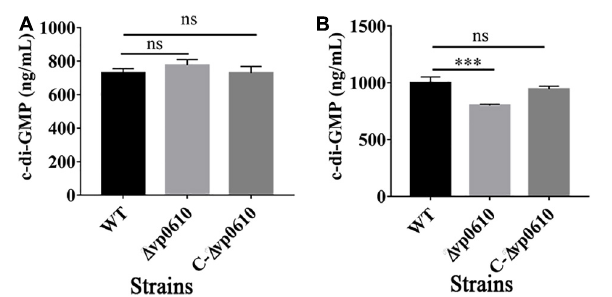
FIGURE 4 | VP0610 modulates c-di-GMP production. The production of c-di-GMP in WT, (cid:49) vp0610 and C- (cid:49) vp0610 was quantified by measuring absorbance at 254 nm. (A) The production of c-di-GMP was measured at 12 h; (B) The production of c-di-GMP was measured at 24 h. Significance was measured by analysis of variance and Dunnett’s test comparison for differences from c-di-GMP production. *** p < 0.001; ns, non-significant.